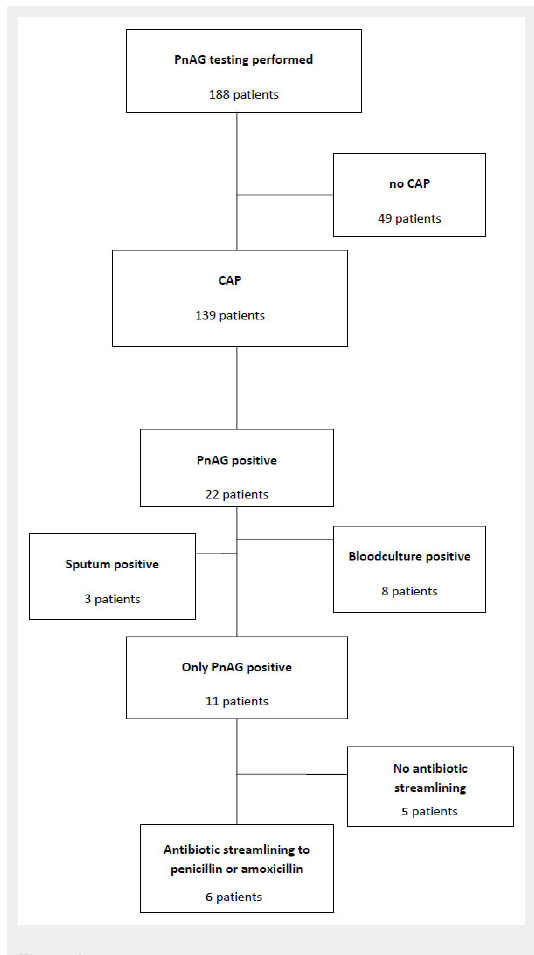
Patients in whom PnAG Test was performed. PnAG = Binax Now ® urine Pneumococcal Antigen